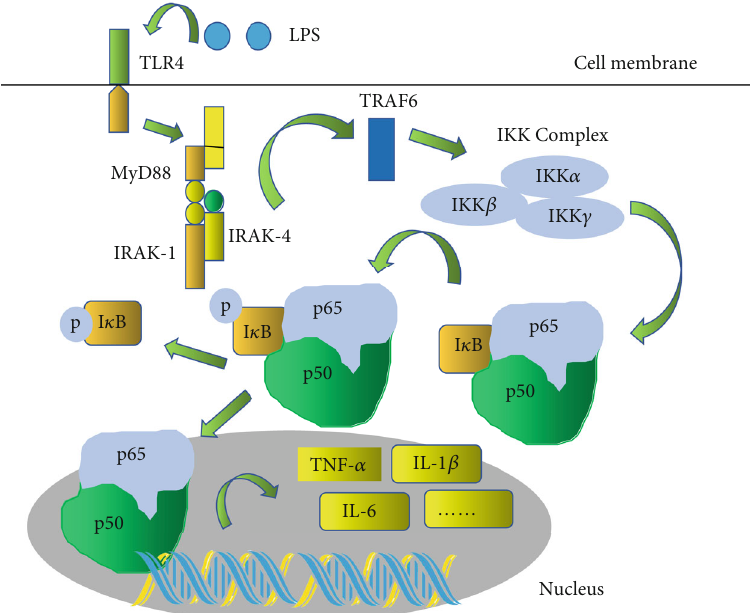
Figure 7: Regulation of LPS-induced TLR4/NF- κ B signaling pathway by ubiquitination and phosphorylation. When NF- κ B is not subjected to external stimulation, it can induce the assembly of an inactive I κ B/p50/p65 trimer. After LPS stimulation, the activated TLR4 fi rstly forms a complex with MyD88. Then, the MyD88 complex promotes the phosphorylation of IRAK4, thereby further phosphorylates TRAF6, while detaching from MyD88. Ubiquitination of TRAF6 induces downstream IKK-mediated NF- κ B signaling pathway, triggering downstream I κ B phosphorylation and inactivation, which leads to NF- κ B dimer breaking away from I κ B, thereby entering the nucleus and acting on the original NF- κ B response element, that is, the gene locus of binding to NF- κ B. Thereafter, the transcriptional translation process is initiated, which leads to the expression of downstream genes related to in fl ammatory factors and